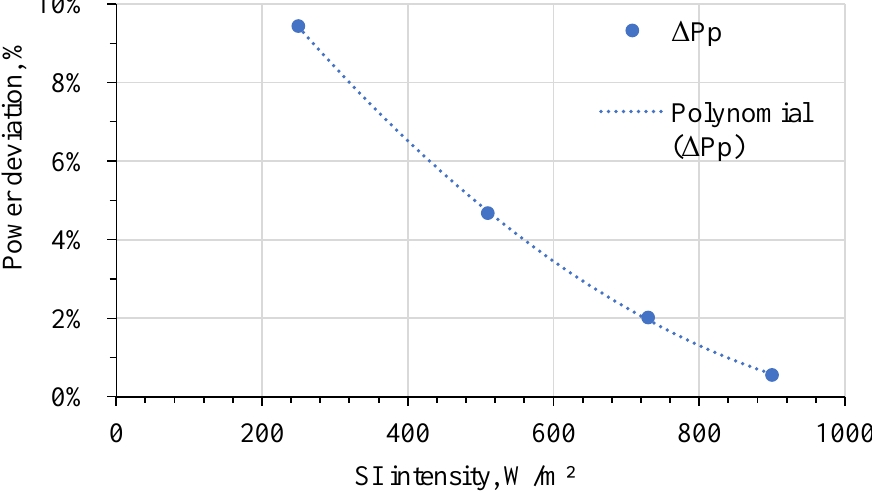
Figure 13. Reducing the power take-off of the PVM from the maximum possible according to VWC, depending on the SI intensity: (ΔPp) indicators of deviation in the generated power from the point of maximum power of PVM; (Polynomial ΔPp) interpolation curve characterizing the dependence of the ΔPp.